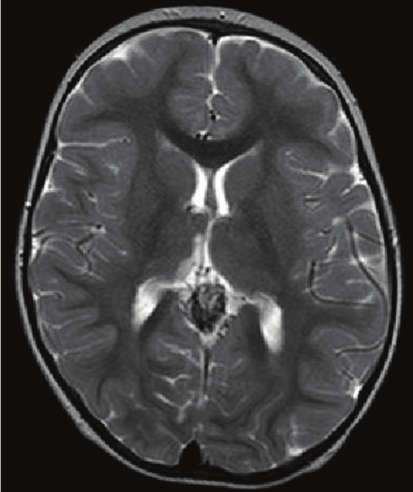
Figure 10: MRI follow-up control after the second embolization (T2-weighted): Vein of Galen still patent, but significant decrease in seizure. NBCA-casts in the sack.